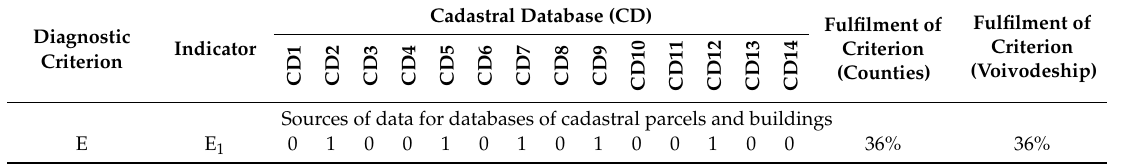
Table 13. Evaluation of Cadastral Databases Based on Criterion